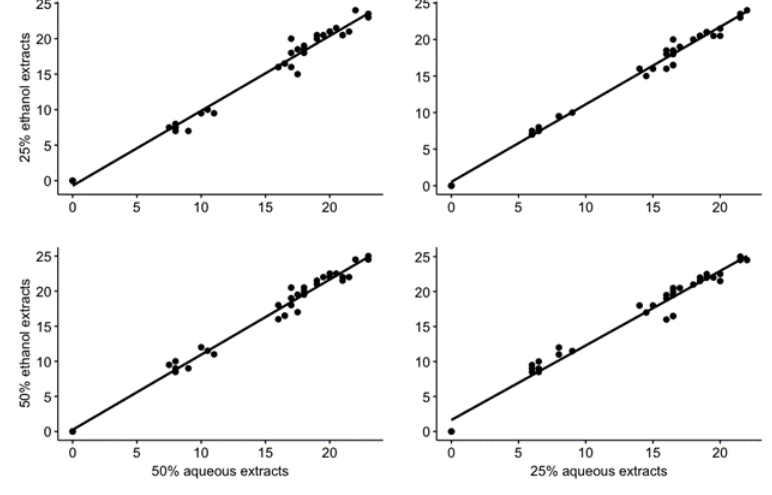
Figure 5 e relationships between aqueous extracts and ethanol extracts.